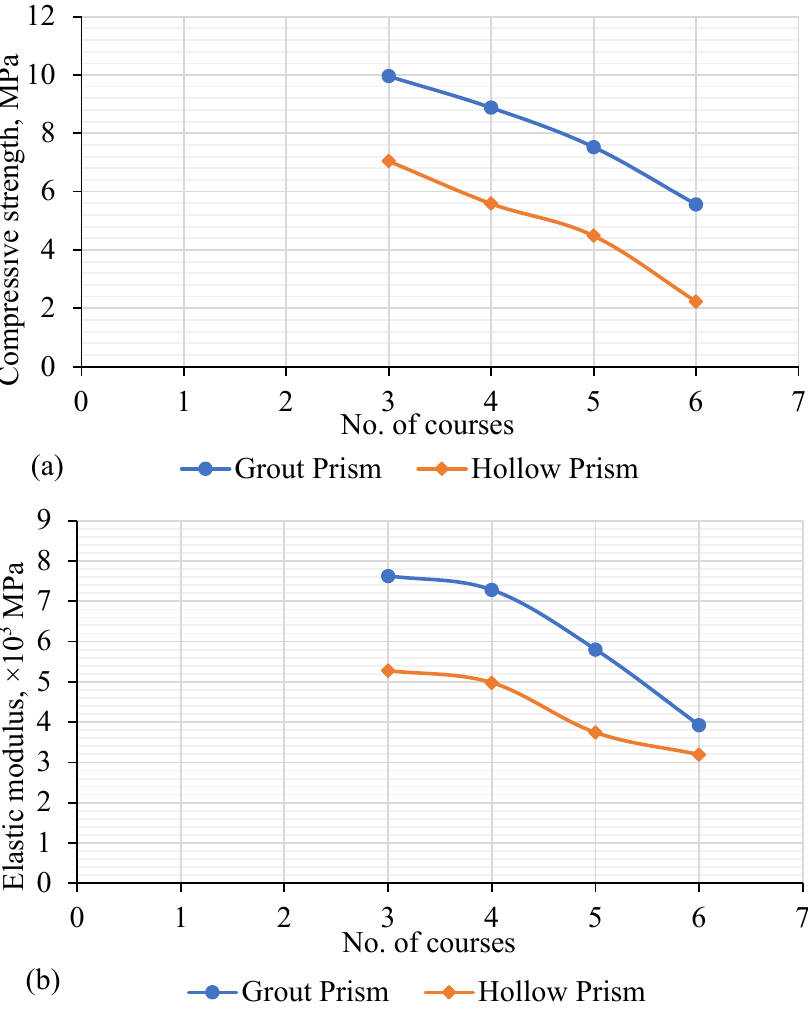
Figure 13. Effects of slenderness ratio on the hollow and grouted prism. ( a ) Prism strength; ( b ) prism elastic modulus.